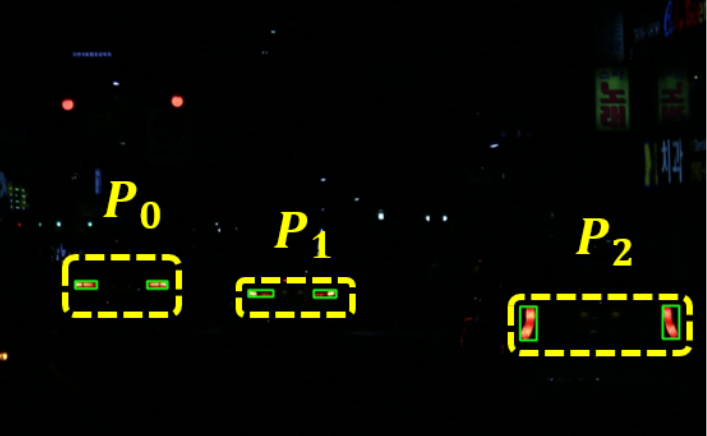
Figure 20. Taillight pairing